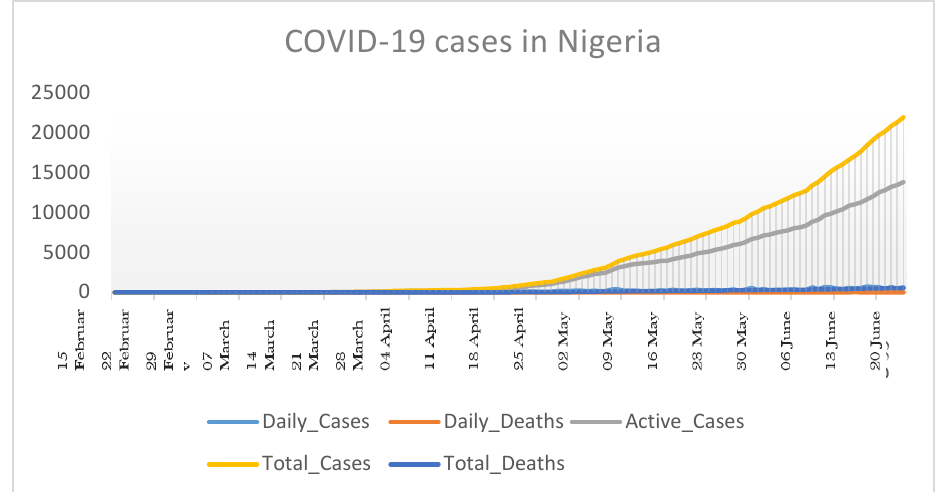
F ig. 4. Chart showing the trend of COVID-19 cases in Nigeria from June 15th to 24th,